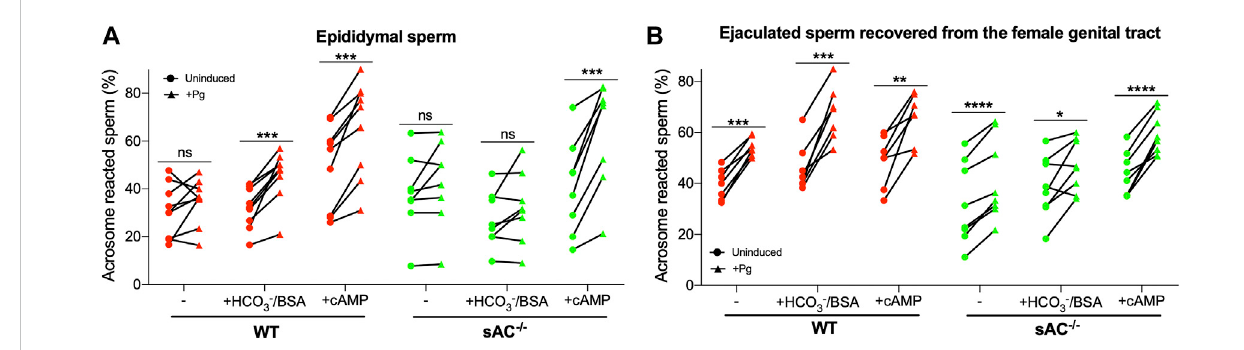
FIGURE 3 Progesterone-induced AR of epididymal (A) and ejaculated (B) WT (red symbols) and sAC − / − (green symbols) sperm incubated in the absence ( − ) or presence of 20 mM